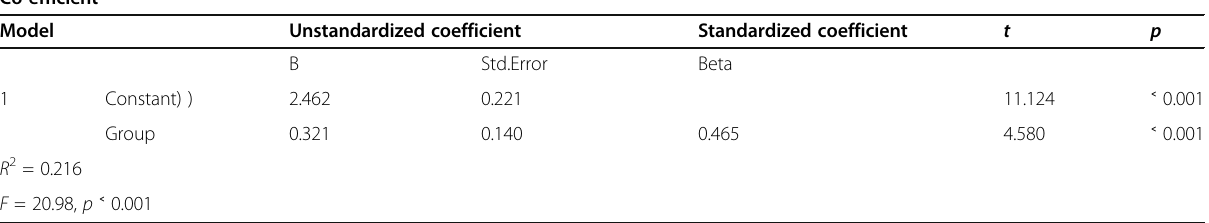
Table 5 Linear regression for prediction of VAS score 28 Co